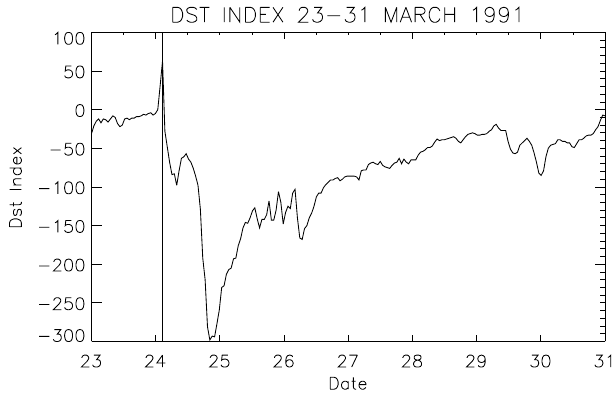
Fig. 1. The Dst index from 23 to 31 March 1991. The dashed line indicates the time of maximum Dst, and is defined as the start of the